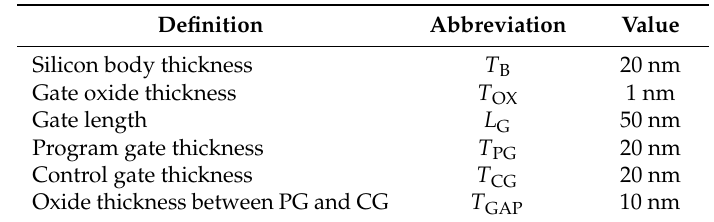
Figure 1. Schematic structure diagrams for recessed-channel reconfigurable field-effect transistor (RC-RFET). It features the vertically stacked polarity gate (PG) and control gate (CG) separated to each other with an oxide gap. Table 1. Simulated device parameters.